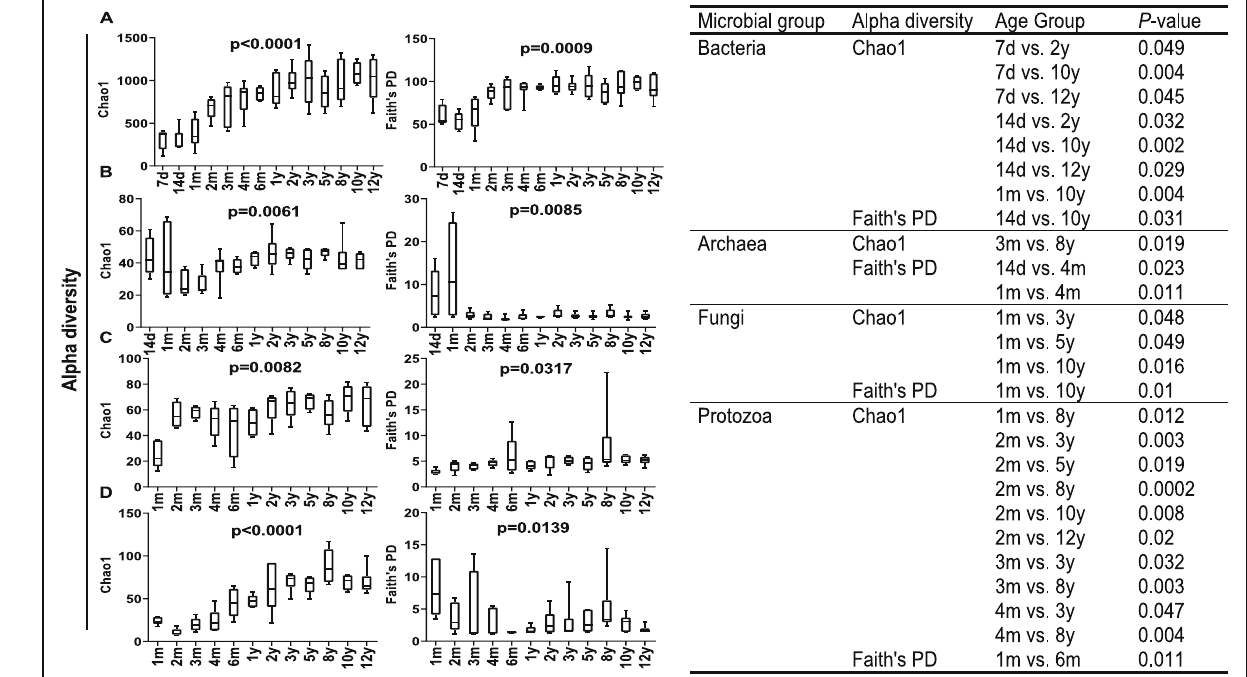
Fig. 2 Chao1 index and Faith ’ s phylogenetic diversity of rumen bacteria ( a ), archaea ( b ), fungi ( c ) and protozoa ( d ). The table on the right shows the statistical